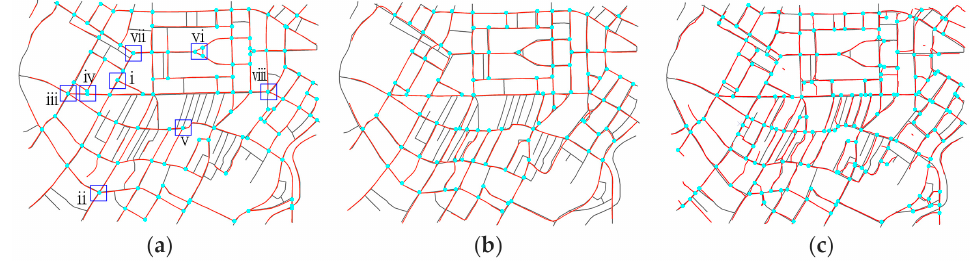
Figure 11. Extracted intersections (highlighted points) and road network (red lines) overlapped with the ground truth map (grey line) of the Chengdu dataset. ( a ) Intersections and road network extracted by the proposed method; ( b ) intersections and road network extracted using Davies’s method; ( c ) and intersections and road network extracted using Ahmed’s method.